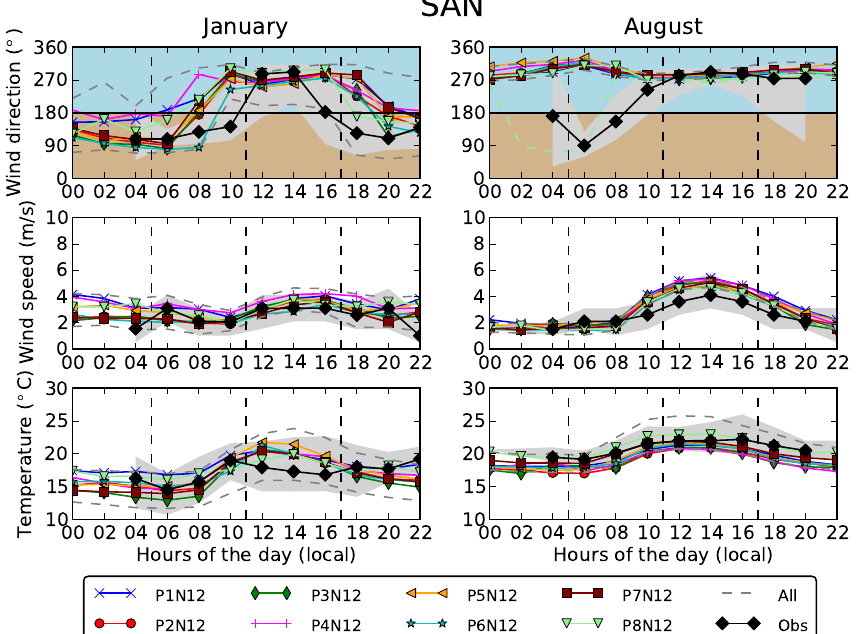
Fig. 3. Diurnal cycle of the surface wind direction, wind speed and temperature for the eight PBL schemes and the observations at San Diego airport in January and August 2009 (local time) using medians. For the wind direction, the blue area represents wind from the west while the tan area is for winds from the east. The grey envelope represents the upper and lower quartiles of the observations. The grey dotted line shows the upper and lower quartiles for all the simulations together. The green dotted line in the august wind direction shows the upper and lower quartile for the P8N12.